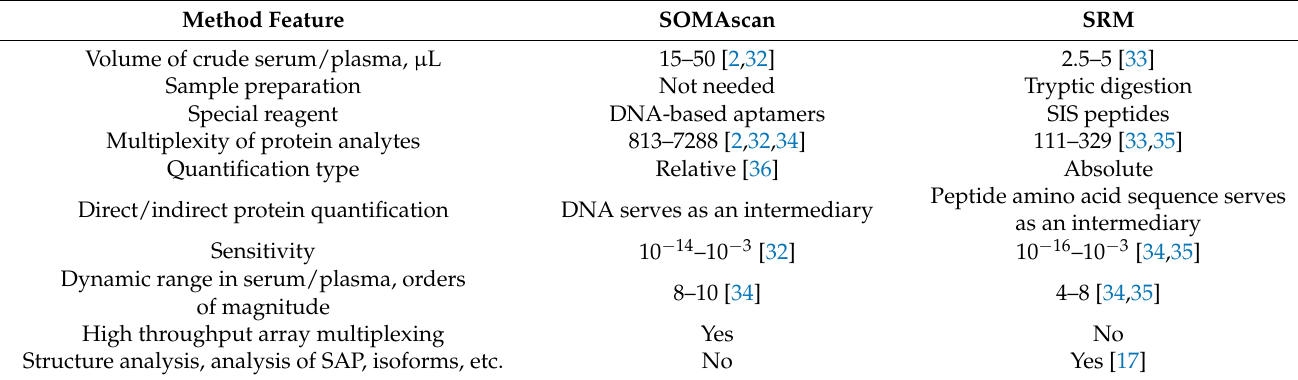
Table 1. Comparison of the mass spectrometric SRM (selected reaction monitoring) approach and aptamer-based SOMAscan platform for protein measurement in human